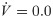
Performance of the motif 1 zero-order controller with transporter mediated compensatory flux (Eqs 16–18).Phase 1: constant volume V and constant k3. Initial concentrations and rate constant values: V0 = 25.0, V˙=0.0, A0 = 0.0, E0 = 0.0, M0 = 4 × 104, k2 = 1.0, k3 = 2.0, k3˙=0.0, k4 = 20.0, k5 = 1 × 10−6, k6 = 10.0, k7 = 1 × 10−6. The controller keeps A at its theoretical set-point, Asettheor=k4/k6=2.0 (Eq 19). Phase 2: rate constants remain the same as in phase 1, but V increases linearly with V˙=2.0, while k3 remains constant at k3 = 2.0. In agreement with Eq 20, the controller shows an offset below Asettheor with Ass = 1.11. Phase 3: V continues to increase with the same speed while k3 starts to increase linearly with k3˙=1.0. As indicated by Eq 20 the controller now breaks down and A goes to zero as V and k3 increase.